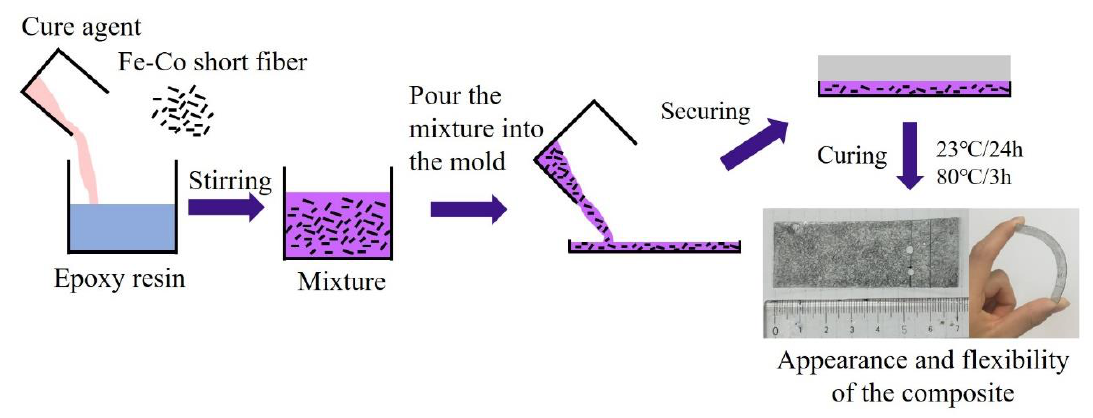
Figure 1. Fabrication process of the discontinuous Fe-Co fiber/epoxy composite.